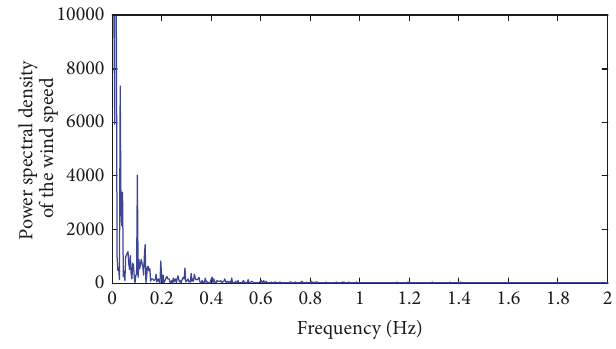
Figure 4: Power spectral density of the wind.